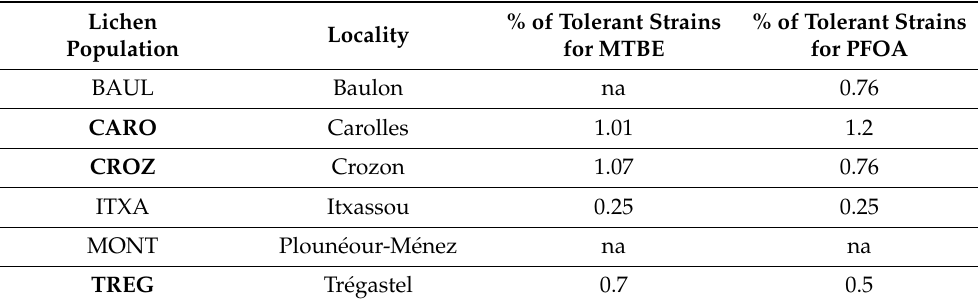
Table 2. Percentage of R. geographicum -associated bacteria highly tolerant to both MTBE and PFOA (when considering a tolerance coefficient ≥ 2). na indicates that any strain from the specific locality was identified with a tolerance coefficient ≥ 2. Localities indicated in bold correspond to habitats that have been subjected to oil spills in their history. % of Tolerant Strains % of Tolerant Strains Lichen Locality for MTBE for PFOA Population BAUL Baulon na 0.76 CARO